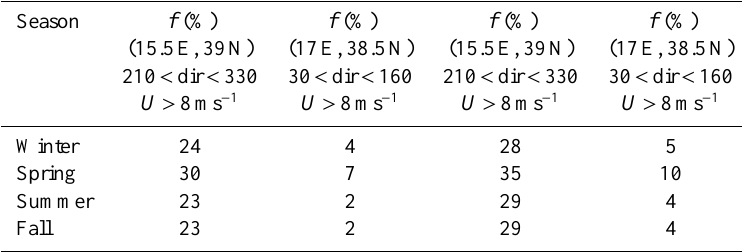
Table 2. Seasonal wind occurrences f (%) for 2007–2008, from the ECMWF analysis at 850hPa. Second and fourth columns are for grid point (15.5E, 39N), third and fifth columns are for grid point (17E,